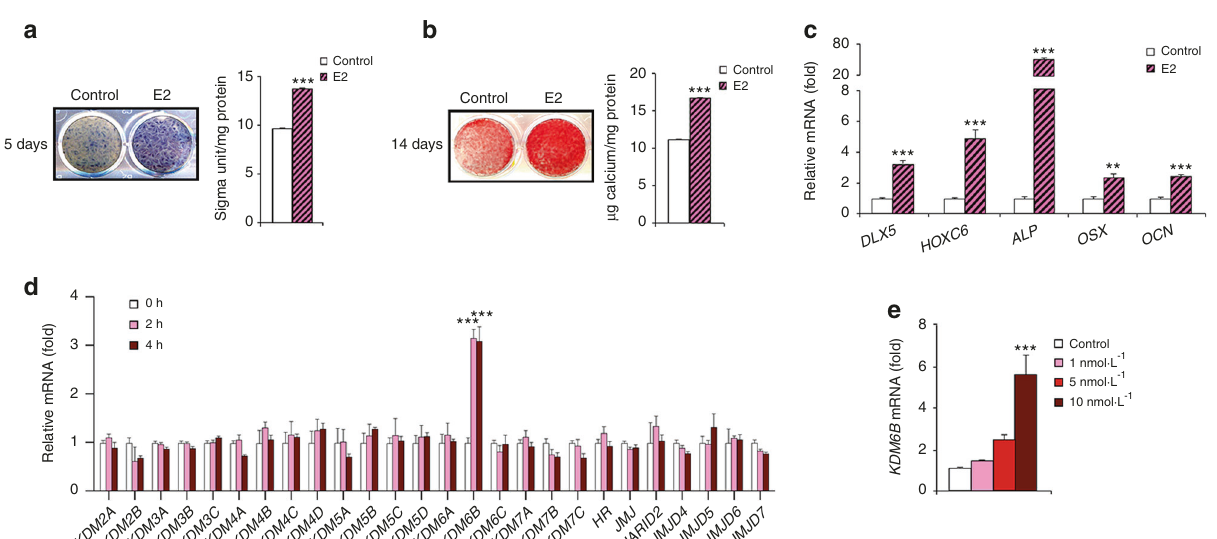
Fig. 1 E2 increases osteogenic differentiation and induces KDM6B in DMSCs. a Alkaline phosphatase staining and quanti fi cation after 5 days of treatment in osteogenic media with and without E2. b Alizarin Red S staining and quanti fi cation after 14 days of treatment in osteogenic media with and without E2. c qRT-PCR of osteogenic genes ( DLX5, HOXC6, ALP, OSX, OCN ) upon E2 treatment in DMSCs. d qRT-PCR of epigenetic regulatory genes upon E2 (10 nmol·L – 1 ) treatment at 2 and 4 h in DMSCs. e qRT-PCR of KDM6B in different E2 concentrations (1, 5, 10 nmol·L – 1 ) at 2 h. Data are presented as the mean ± SEMs ( a , b , n = 9, c – e n = 3). For a and b , the control and E2-treated cells were compared by the two-tailed t test. For c and d , data are shown as fold expression of target genes after normalization to the control. For c , control and E2- treated cells were compared by two-tailed t -tests. For d , the groups were compared by two-way ANOVA with a Bonferroni post hoc test. For e , the groups with different concentrations of E2 were compared by one-way ANOVA with Tukey ’ s post hoc test. Asterisks were assigned to P values with statistical signi fi cance (** P < 0.01; *** P <